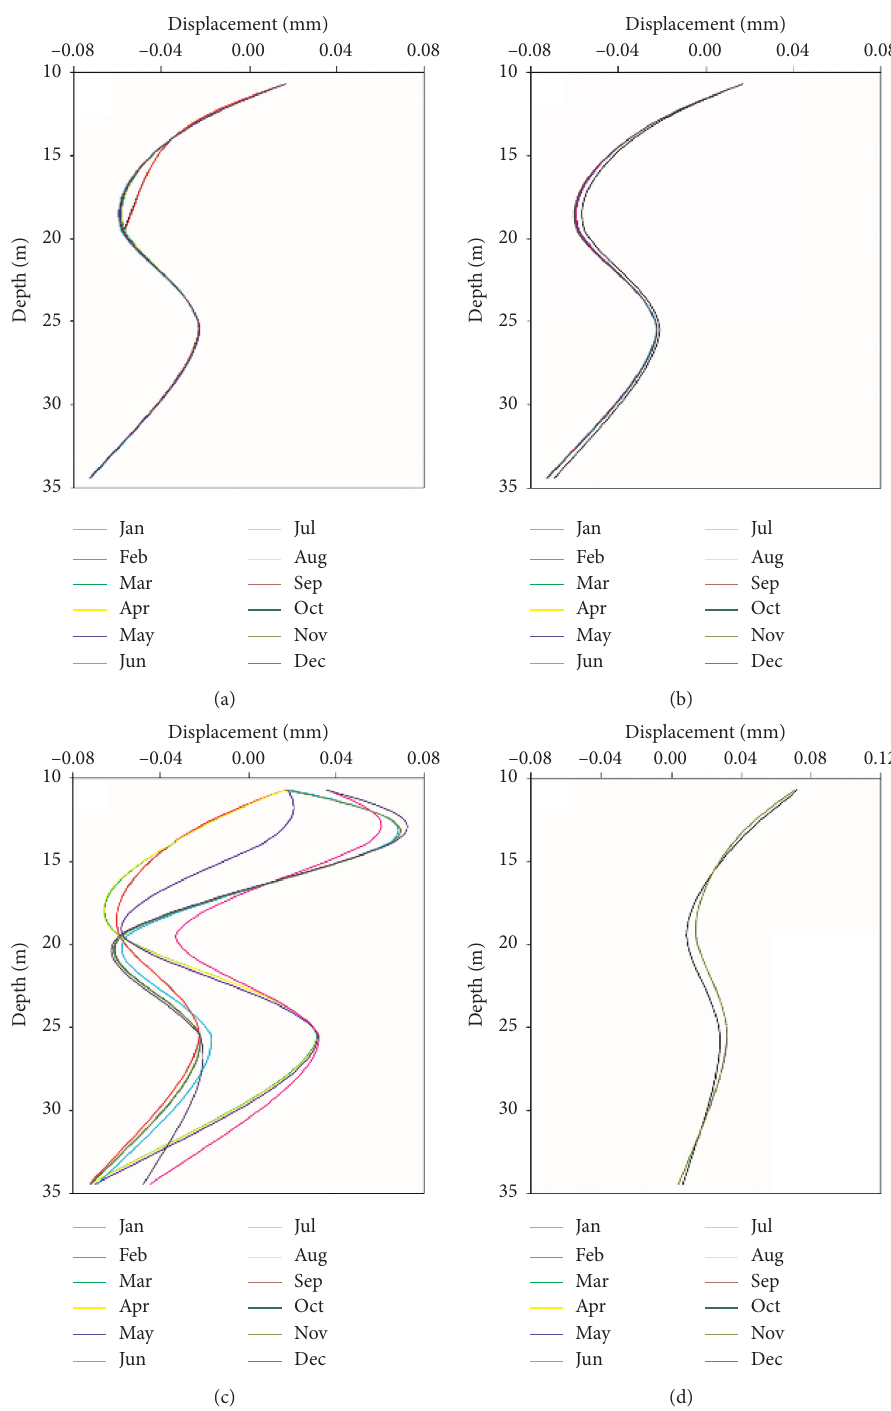
Figure 12: Relationship between landslide displacement and different soil depth in different years in the ZK1 monitoring point: (a) 2009; (b) 2010; (c) 2011; (d) 2012. The results of other monitoring points (ZK2 and ZK3) are attached in the supplementary files (Figures S4 and